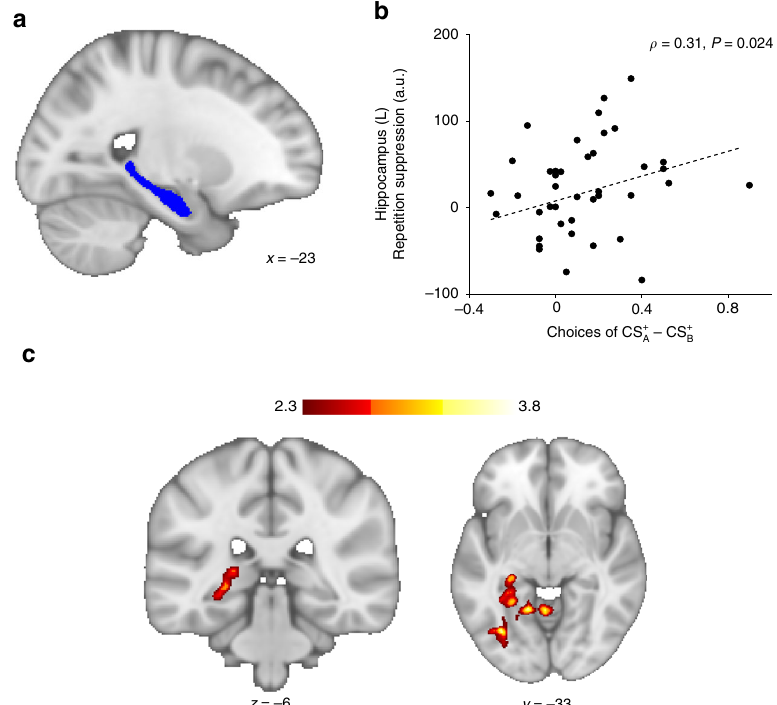
(cid:2) US þ relative to CS þ (cid:2) US þ , A B and overall choice probability of A and CS þ preference and PRE – POST change of A B